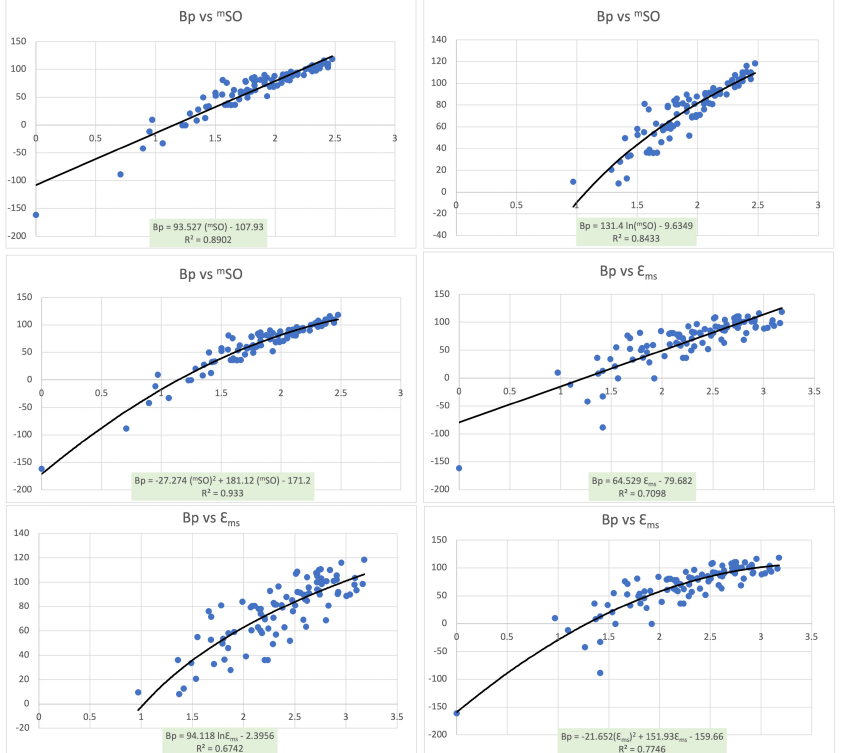
Figure 3. The scattering of Bp (boiling points) with each of the topological indices m SO and E MS for the linear, logarithmic, and quadratic regressions along with the regression equations and R 2 (coefficient of determination).